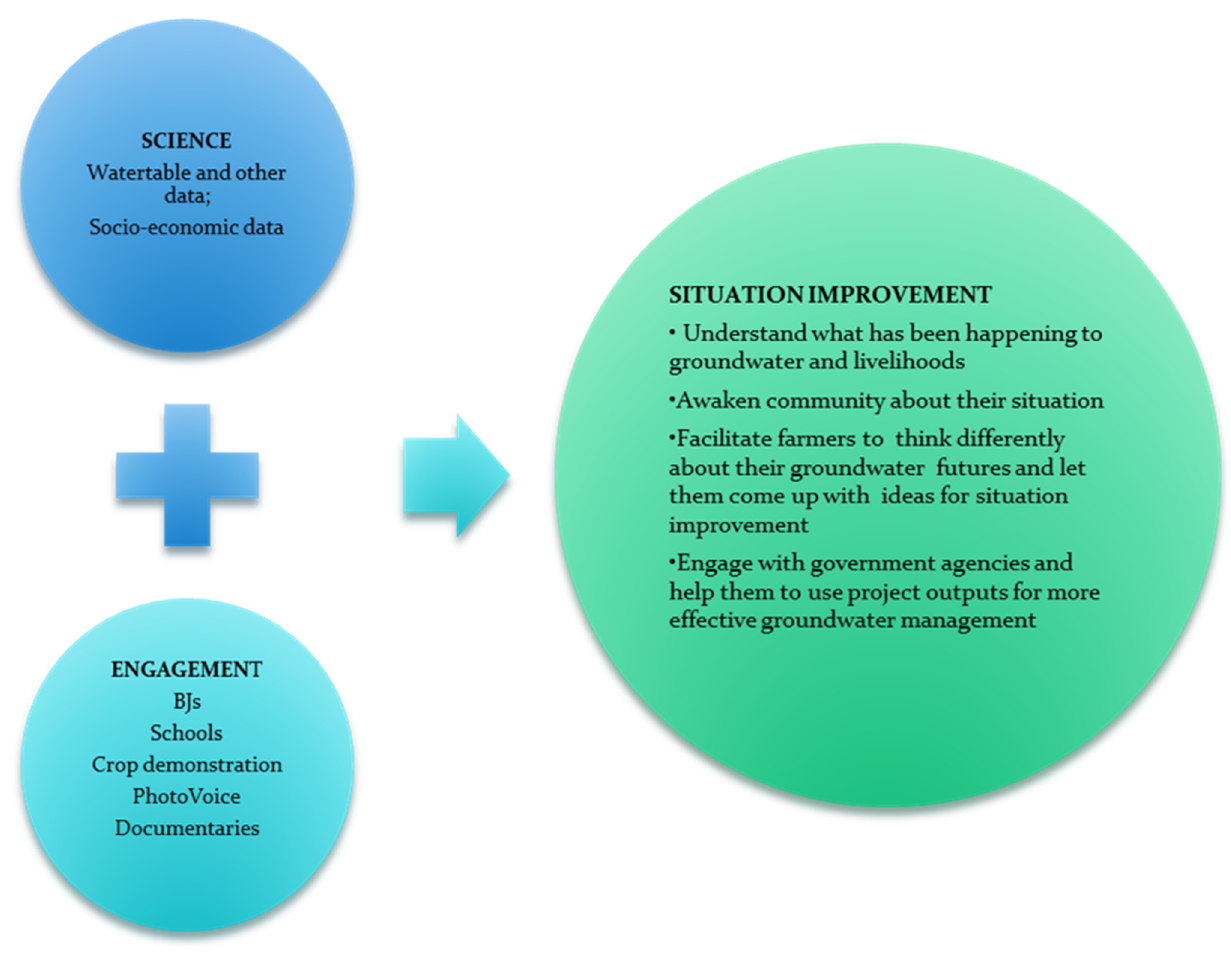
Figure 4. Study approach in MARVI